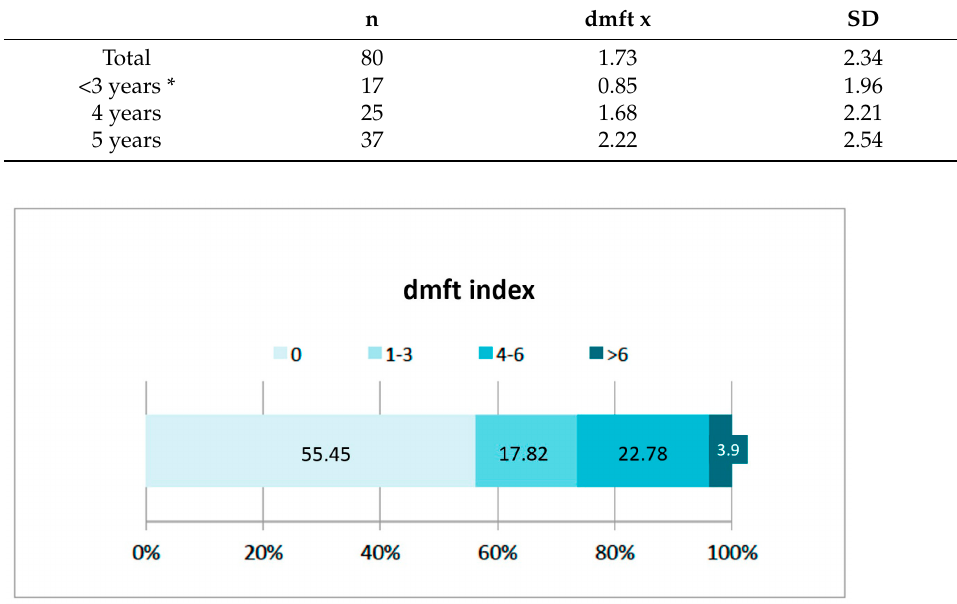
Figure 1. Percentage of children and distribution per dmft.